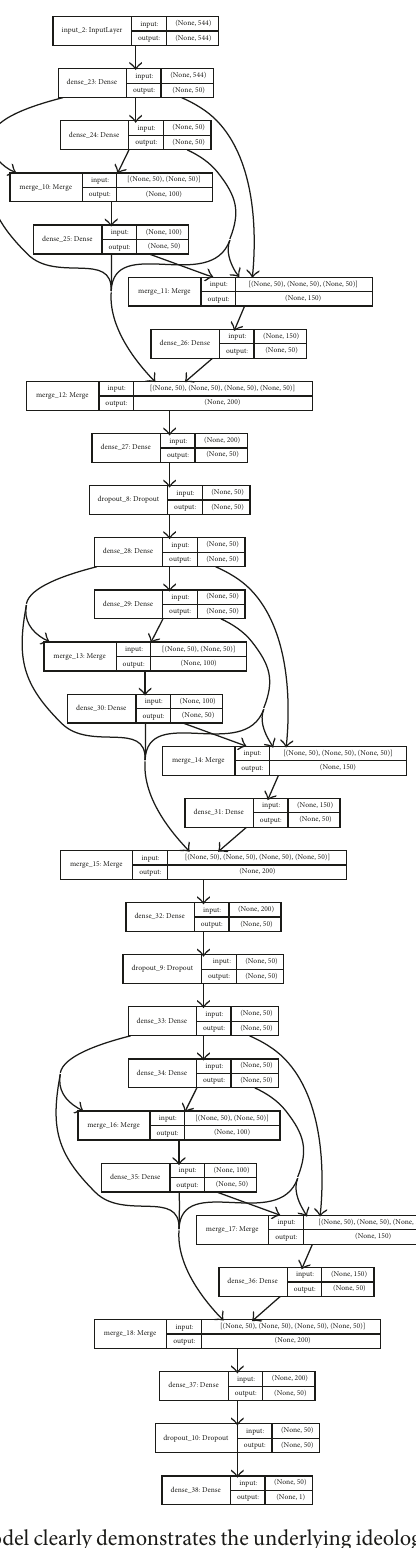
Figure 3: The “ub deeper x2” model. This model clearly demonstrates the underlying ideology of how the nodes of the network interact with each other. Zooming in to “merge 8” one can clearly see distinct output paths travelling into the layer. The “merge 8” layer concatenates the outputs of “dense 11,” “dense 12,” and “dense 13” to form a single large tensor, thus demonstrating how the layers of a block are all directly connected to each other instead of following a more “sequential” flow of